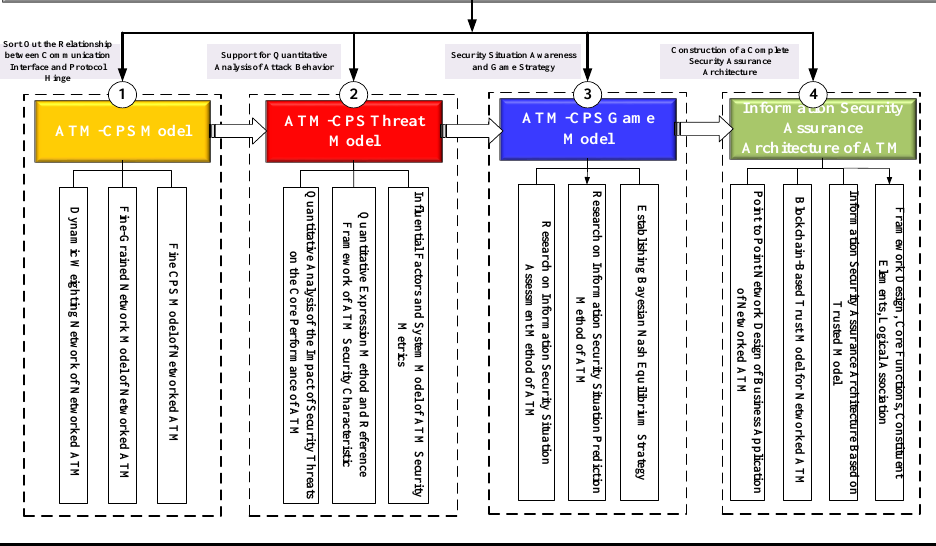
Figure 13. Technical route and measures of the research.